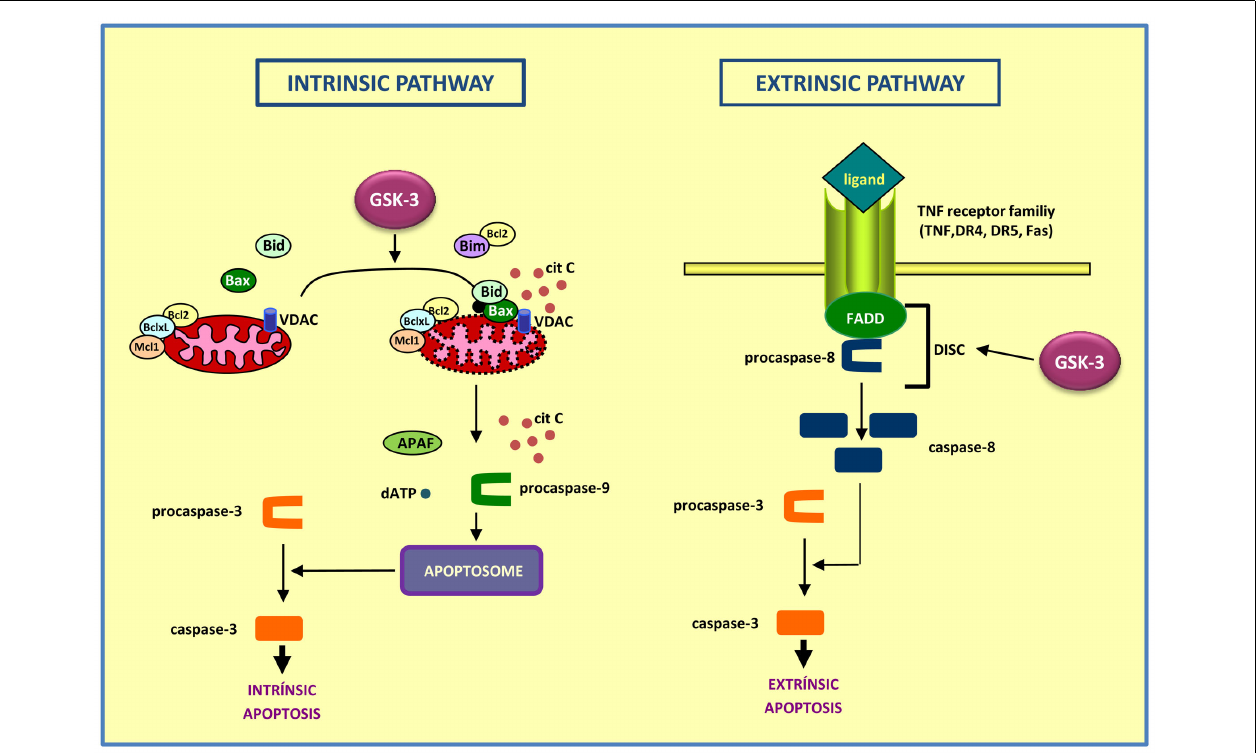
FIGURE 1 | Diagram showing the intrinsic (left) and extrinsic (right) apoptotic pathways. In the intrinsic apoptotic pathway, GSK-3 exerts a pro-apoptotic role, acting on targets as Bax, Bim, andVDAC, thus contributing